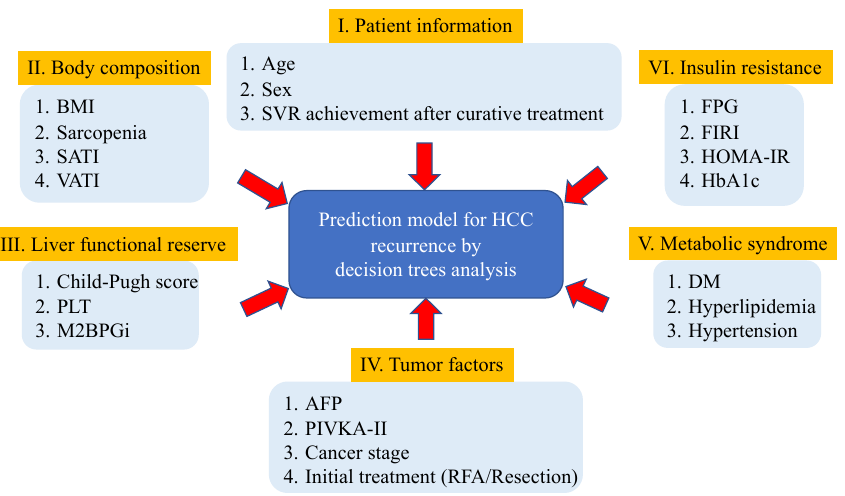
Figure 2. Study outline to evaluate the risk factors affecting hepatitis C virus-related recurrence of hepatocellular carcinoma after curative treatment using decision tree analysis.